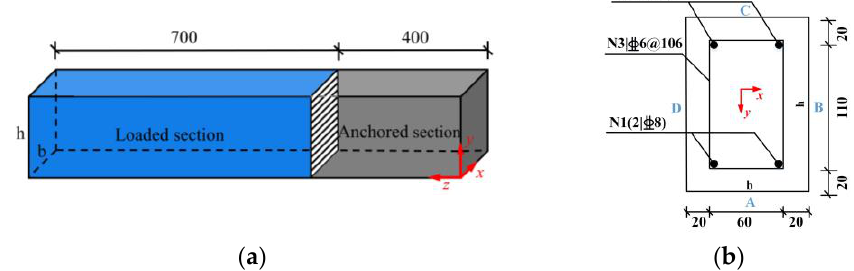
Figure 2. Diagrammatic sketch of the dimensions and section reinforcement of the test piles (unit: mm). ( a ) Dimensions; ( b ) section reinforcement.